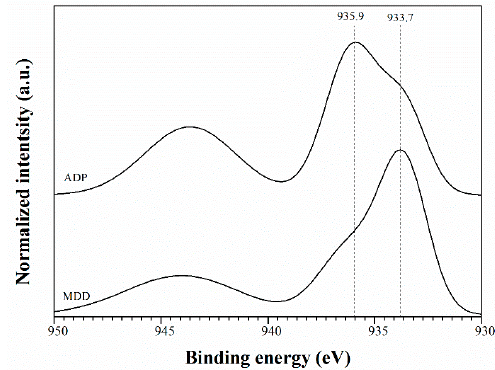
Figure 3. X ‐ ray photoelectron spectroscopy (XPS) spectra of Cu 2p 3/2 region for the CuO/SBA ‐ 15 sample prepared by ADP method (top) and MDD method (bottom).